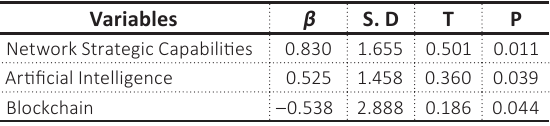
Table 6. Path analysis to employ networks strategic capabilities on leadership